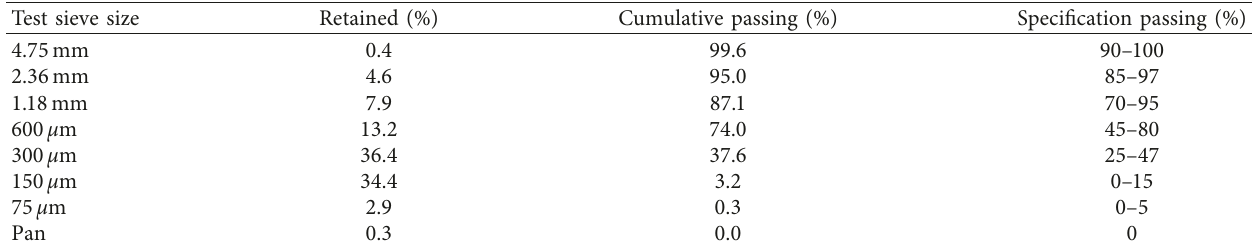
Table 2: Grading of fine